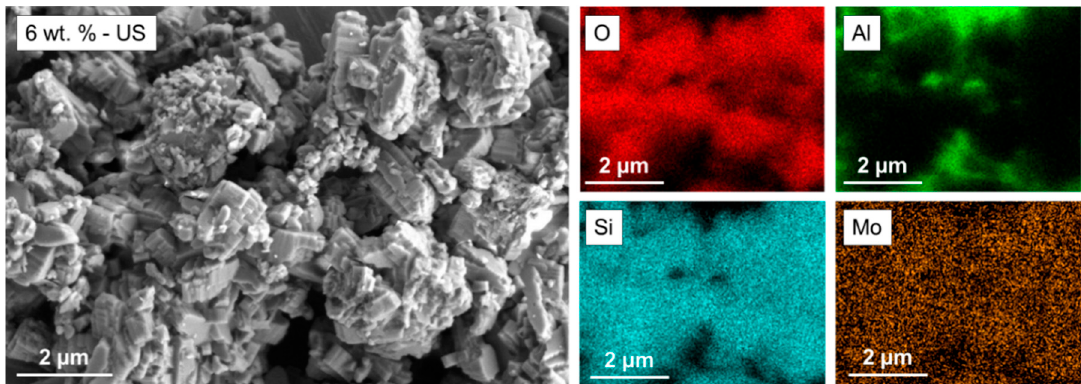
Figure 5. SEM image Mo/ZSM-5 catalyst 6 wt. % prepared with ultrasound and its corresponding EDX mapping for O, Al, Si, and Mo .